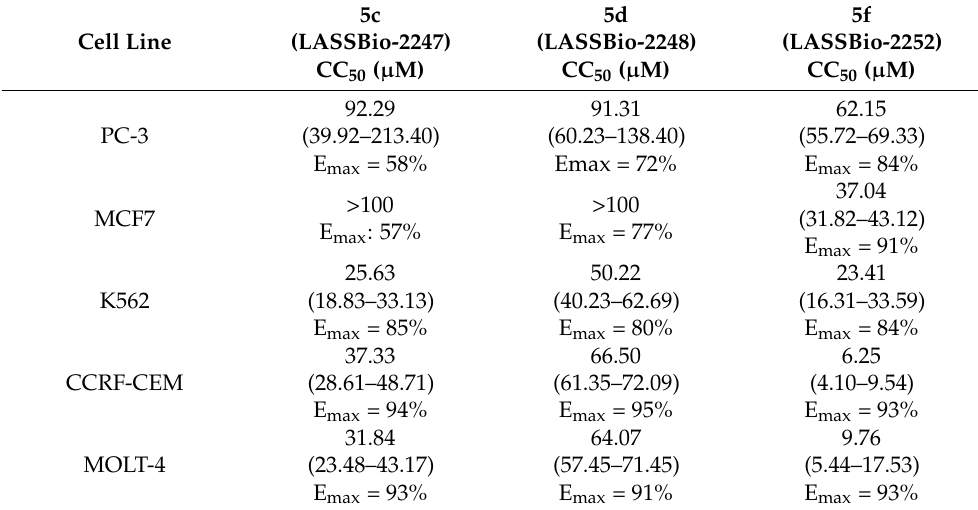
Table 3. CC 50 values calculated from the 72 h MTT cell viability